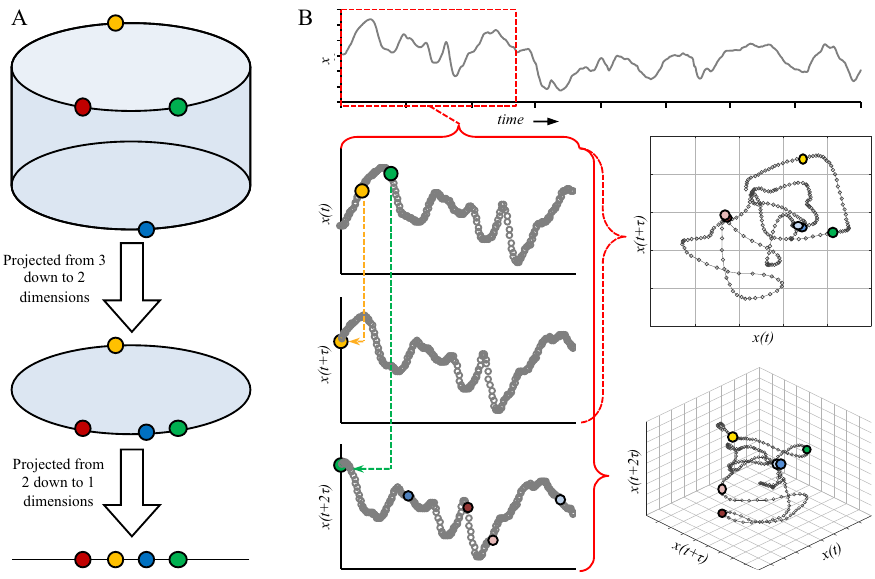
Fig. 2 Illustration of phase space reconstruction (PSR). A Illustration of how downwards projection of system states can result in False Nearest Neighbours (FNN). In the (top) three-dimensional space the red and green states (points) are closest. When projected down to a two- and then a one-dimensional space, the mustard yellow and blue states ‘ falsely ’ appear to be nearer to the red and green states. The inverse process, projection from 1 to 2 dimensions and then from 2 to 3 dimensions reveals, which neighbouring points are ‘ true ’ and which ones are ‘ false ’ (adapted from Boker, 1996). B Illustration of Phase Space Reconstruction and how time-delayed copies of a measured scalar sequence or times series can be employed as surrogate data series to reconstruct an n -dimensional phase space that is isomorphic to the behavioural system ’ s true phase space. Here a three-dimensional phase space is reconstructed for illustration purposes, although a six-dimensional space was employed to analyse the movement data collected for the current study. The coloured states in the bottom surrogate time-series, x ( t + 2 τ ), and in the two- and three-dimensional phase spaces are included to illustrate how the neighbours a state has can change as the dimension of a reconstructed phase space is increased. The dark and light blue points, for example, do not constitute neighbours in the one-dimensional time-series, but do constitute neighbours in both two and three-dimensional space. Conversely, the dark and light magenta points appear to be neighbours in two-dimensional space, but not in three-dimensional space. In phase space reconstruction, surrogate dimensions are added until % FNN = 0. See text for more